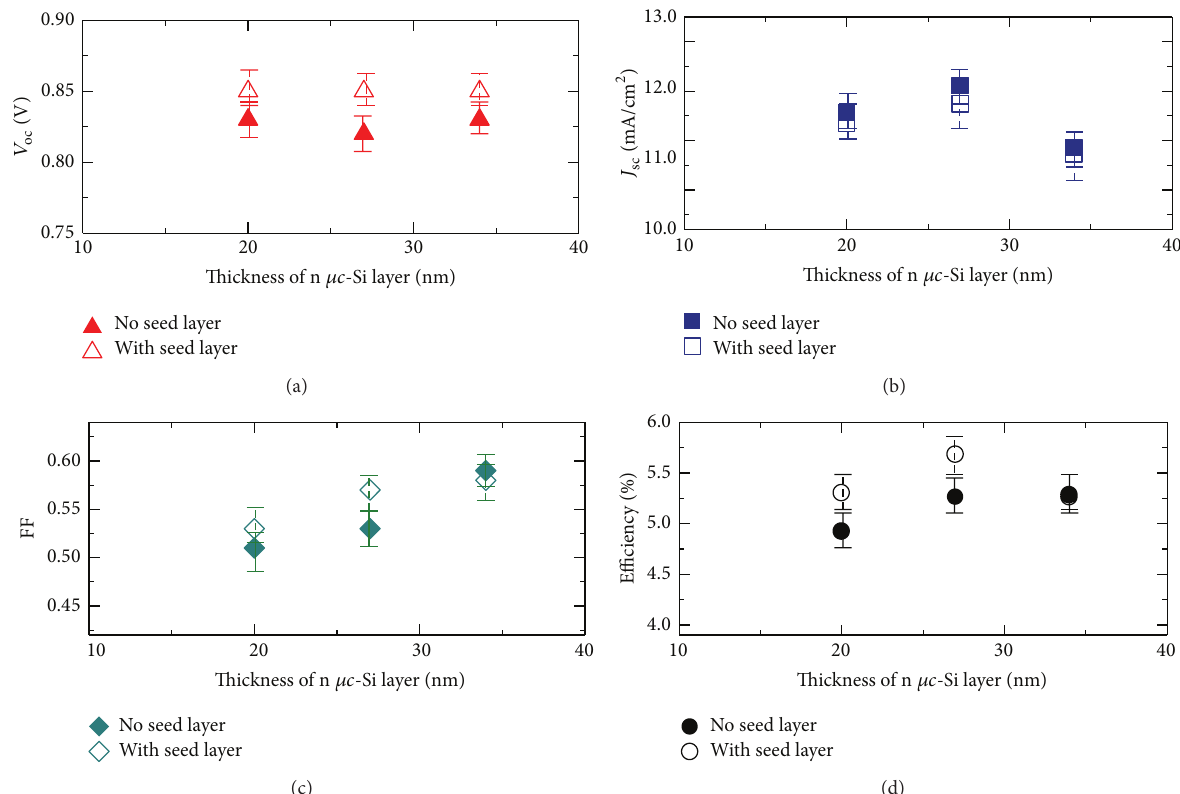
Figure 4: Photovoltaic parameters of flexible n-i-p amorphous silicon solar cells with (blank mark) and without seed layer (filled marks) as a function of thickness of the n 𝜇 c-Si:H layer.